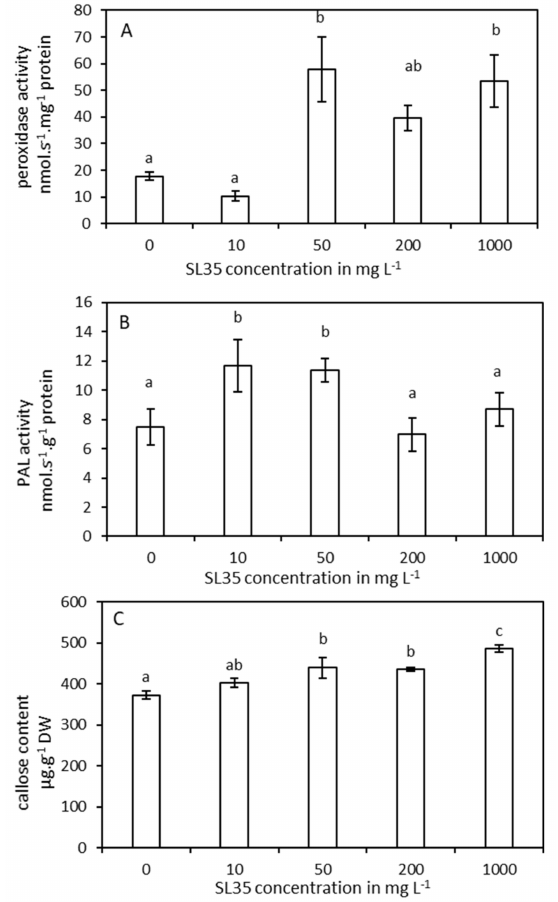
Figure 1. Peroxidase ( A ) and PAL ( B ) specific activities and callose content ( C ) of tomato leaves after treatment with increasing concentration of SL35 diluted in 0.05% Tween 80 (days 1, 3 and 5) and inoculation with B. cinerea at day 8. All samples were collected at day 15 (mean ± SD; n = 15 for peroxidase and PAL activities and n = 3 for callose contents). No letters in common between treatments indicate significant differences ( p < 0.05; one-way